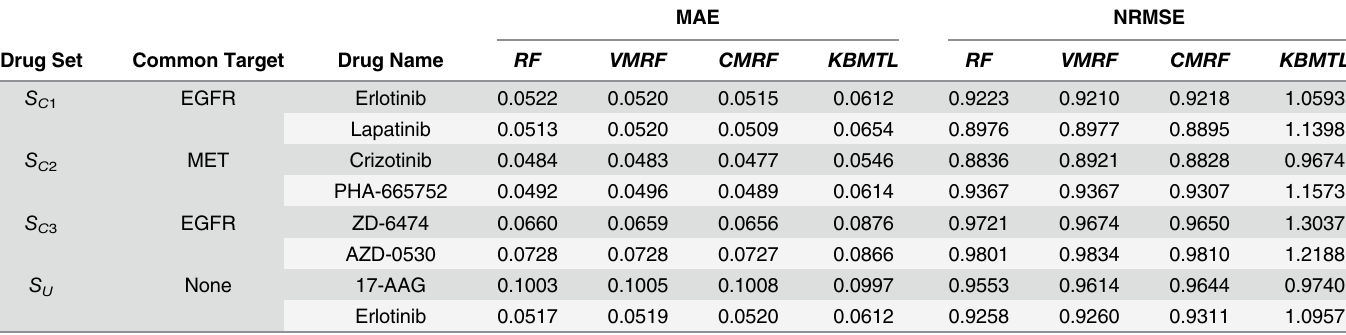
Table 6. 5 fold CV results for CCLE Dataset drug sensitivity prediction for four drug sets in the form of MAE and NRMSE for RF , VMRF , CMRF and KBMTL . MAE NRMSE Drug Set Common Target